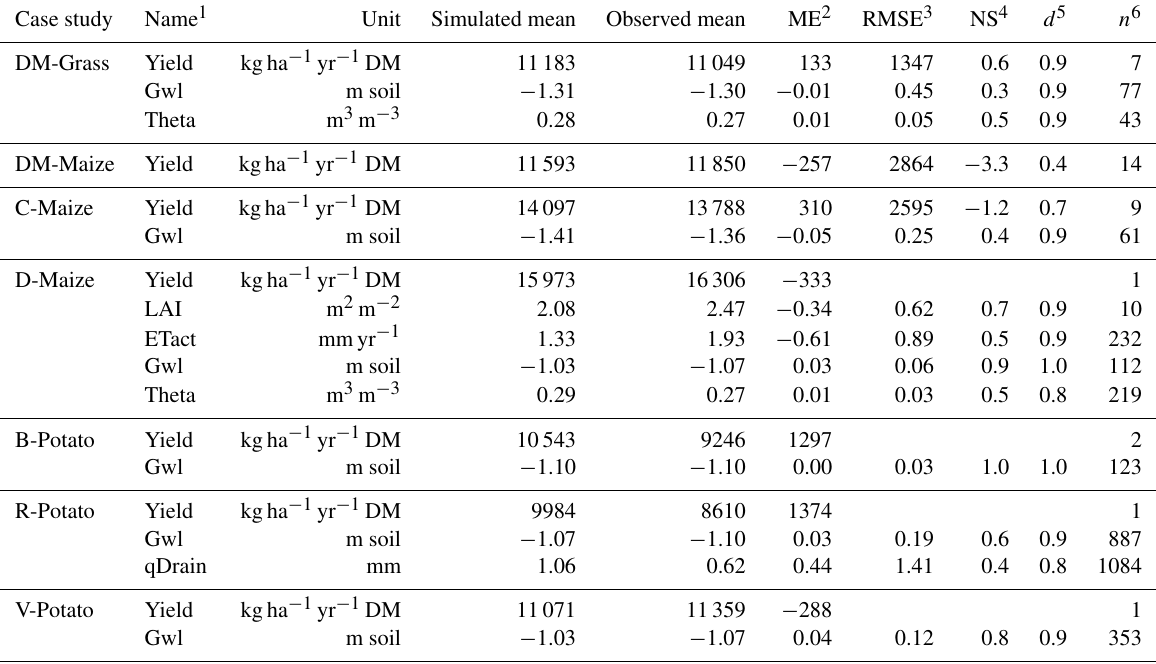
Table 2. Results of Case studies: simulated and observed values. Case study